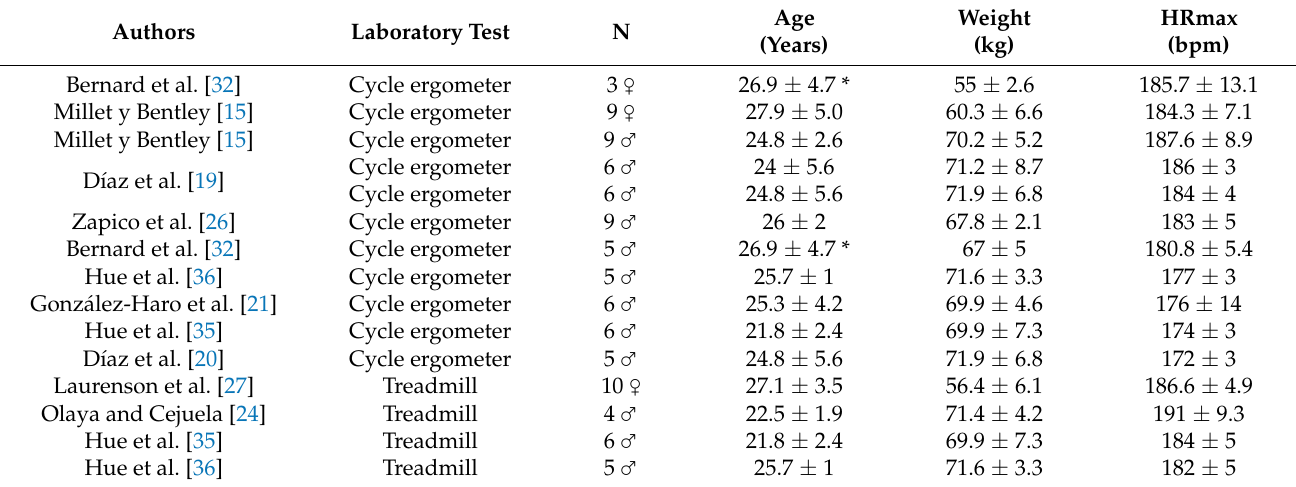
Table 5. Mean ± SD values of HRmax of elite